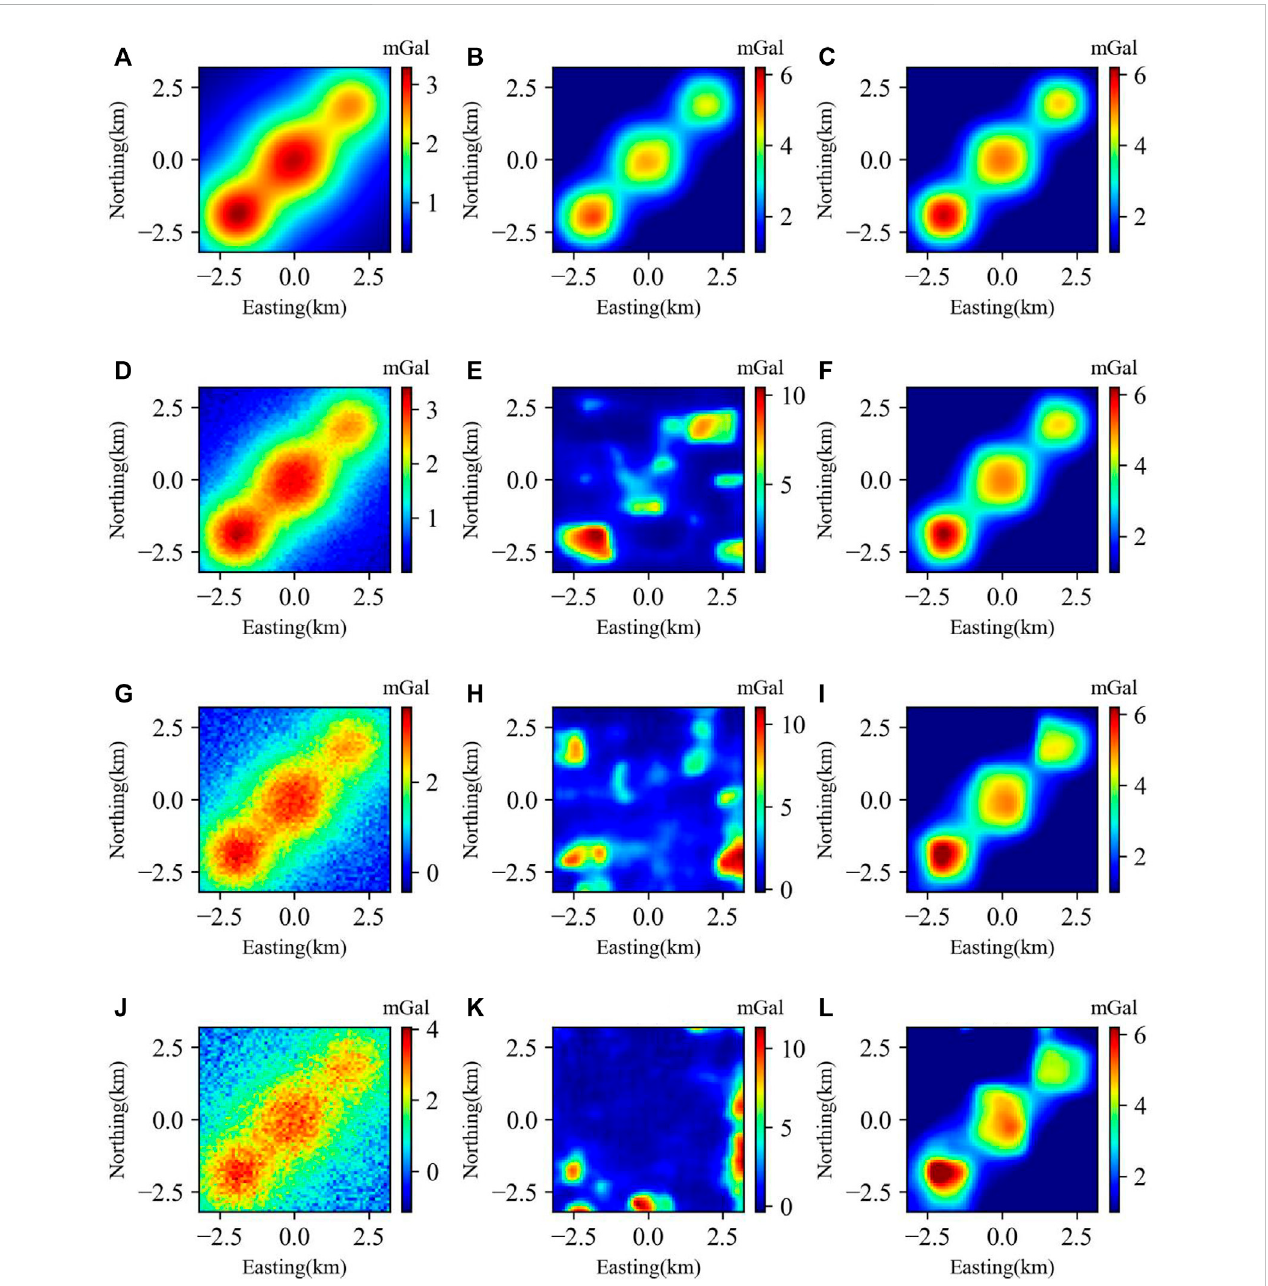
FIGURE 6 Predictedresultsat0 musingtheNFDC-NetmodelandtheDC-Netmodelfordifferentgravityanomalieswithdifferentnoiselevelsat500 m: (A) noise- free gravity anomaly; (B) predicted result using the NFDC-Net model for a noise-free gravity anomaly; (C) predicted result using the DC-Net model for a noise-freegravityanomaly; (D) gravityanomalywith2%Gaussiannoise; (E) predictedresultusingtheNFDC-Netmodelforagravityanomalywith2%Gaussian noise; (F) predicted result using the DC-Net model for a gravity anomaly with 2% Gaussian noise; (G) gravity anomaly with 5% Gaussian noise; (H) predicted result using the NFDC-Net model for a gravity anomaly with 5% Gaussian noise; (I) predicted result using the DC-Net model for a gravity anomaly with 5%Gaussian noise; (J) gravityanomalywith 10% Gaussian noise; (K) predictedresult usingthe NFDC-Net model for agravity anomaly with 10%Gaussian noise; (L) predicted result using the DC-Net model for a gravity anomaly with 10% Gaussian